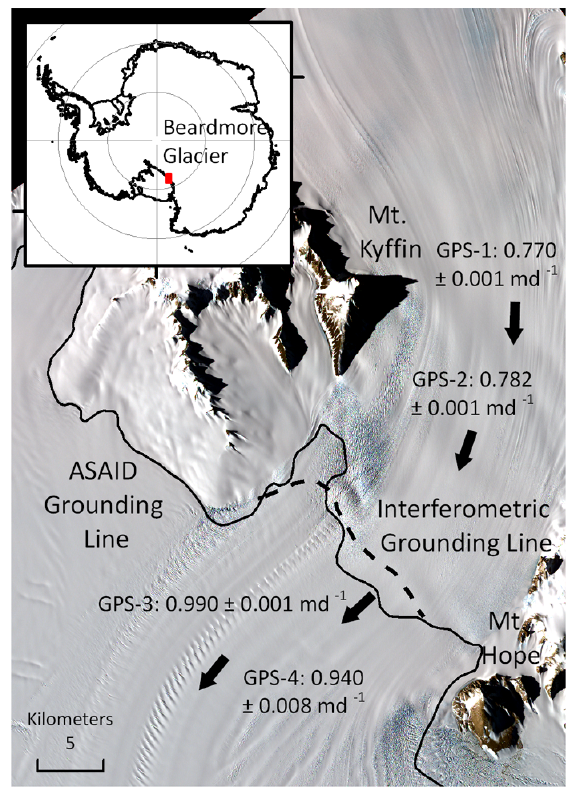
Fig. 1. Beardmore Glacier GPS positions and velocities in Decem- ber 2010 superimposed on an ASTER image from 2008. GPS po- sitions correspond to the centres of arrows. The ASAID (solid line) and interferometric (dashed line) grounding lines are also